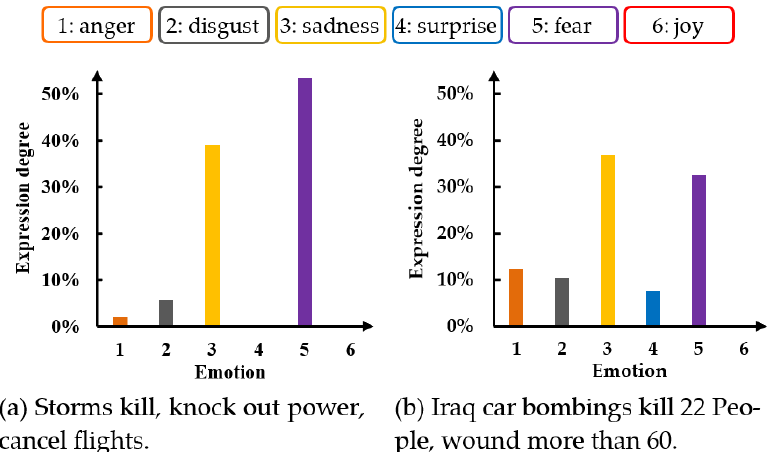
Figure 1. Expression degree of two example sentences in the Semeval dataset of six basic emotions. ( a ) Emotion distribution of sentences with main emotion label is fear; ( b ) Emotion distribution of sentences with main emotion label is sadness.